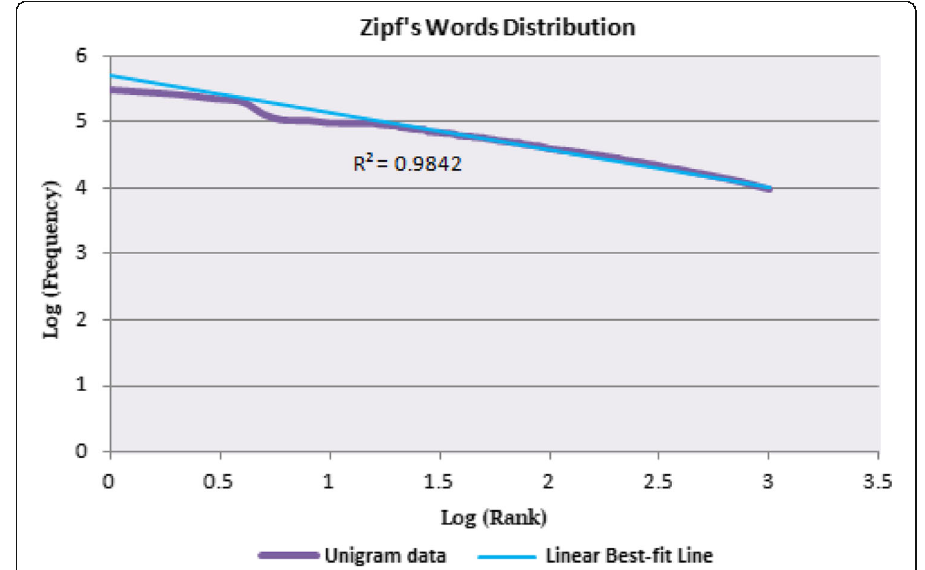
Fig. 3 Zipf ’ s distribution of the top 1000 words in the JUPLag